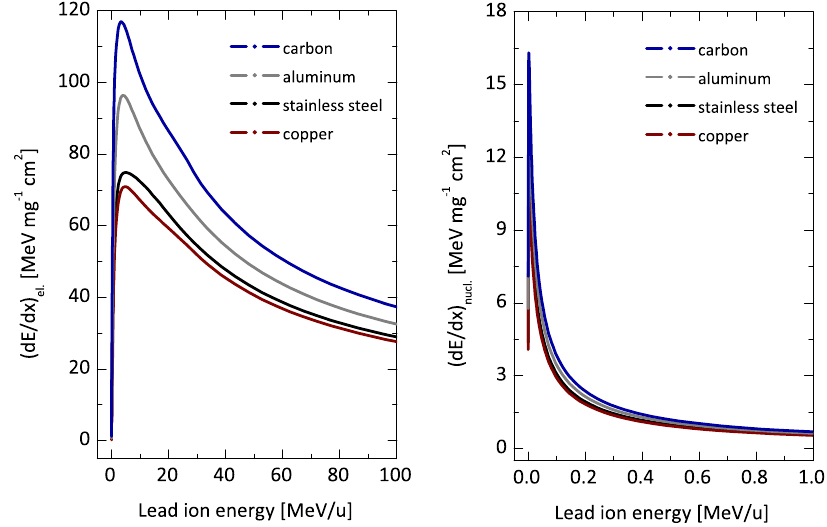
FIG. 7. Electronic (left) and nuclear (right) energy losses dE=dx calculated with SRIM for different lead-ion energies impacting onto carbon, aluminum, stainless steel, and copper